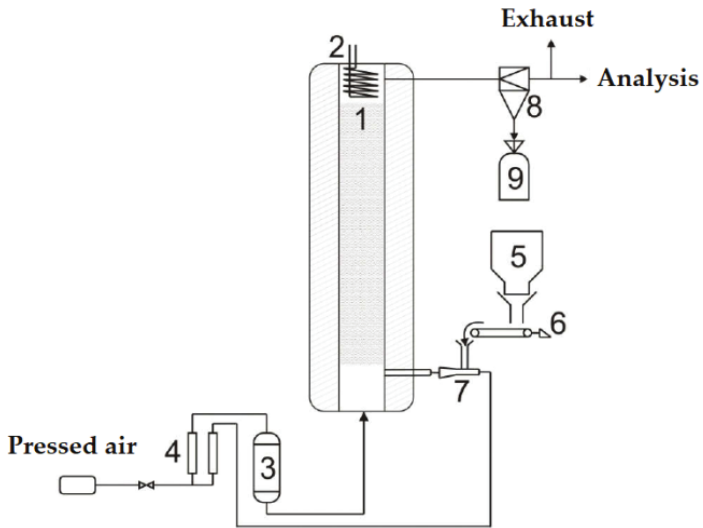
Figure 2. Scheme of the installation for coal combustion in the fluidized bed of a catalyst: 1—reactor; 2—heat exchanger; 3—air heater; 4—rotameters; 5—coal bunker; 6—screw feeder; 7—ejector; 8—cyclone; 9—ash collection bunker.